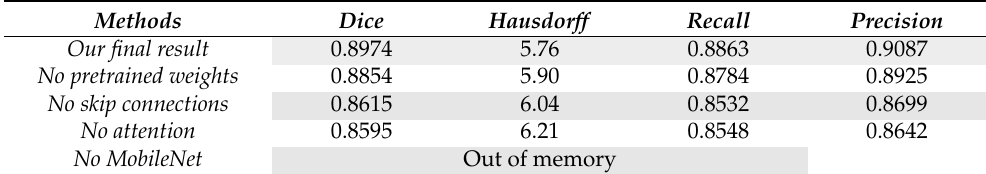
Table 3. Evaluation results for model with and without extra